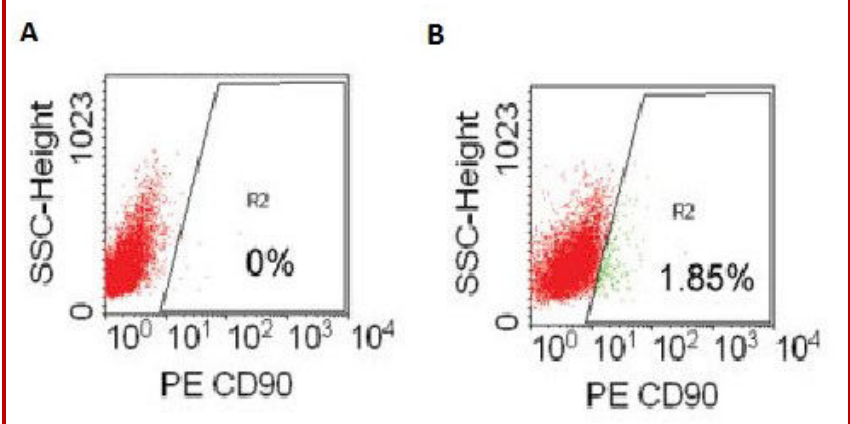
Figure 2: Flow cytometry analysis. Liver cancer tissue samples and normal liver tissue samples were subjected to cell sorting with CD90 + cells. A. Cells from normal liver tissue samples show 0% of CD90 + cells. B. Cells from liver cancer tissue samples show 1.85% of CD90 + cells